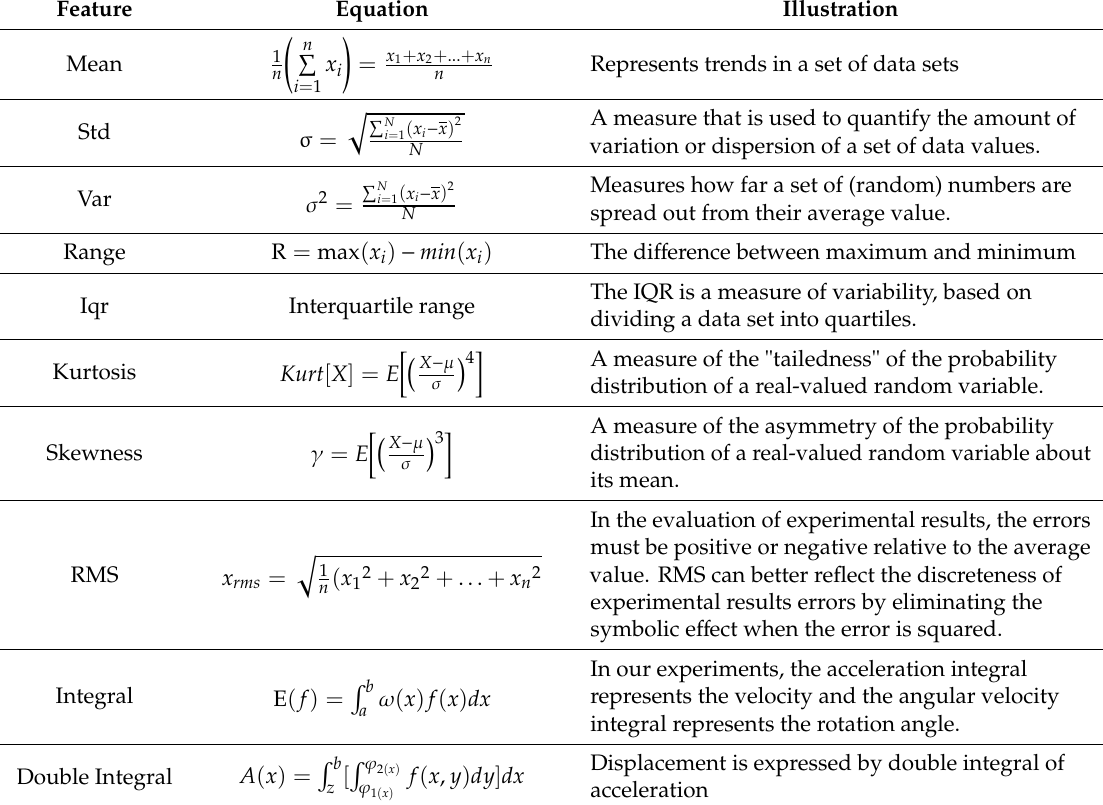
Table A1. Motion Detection